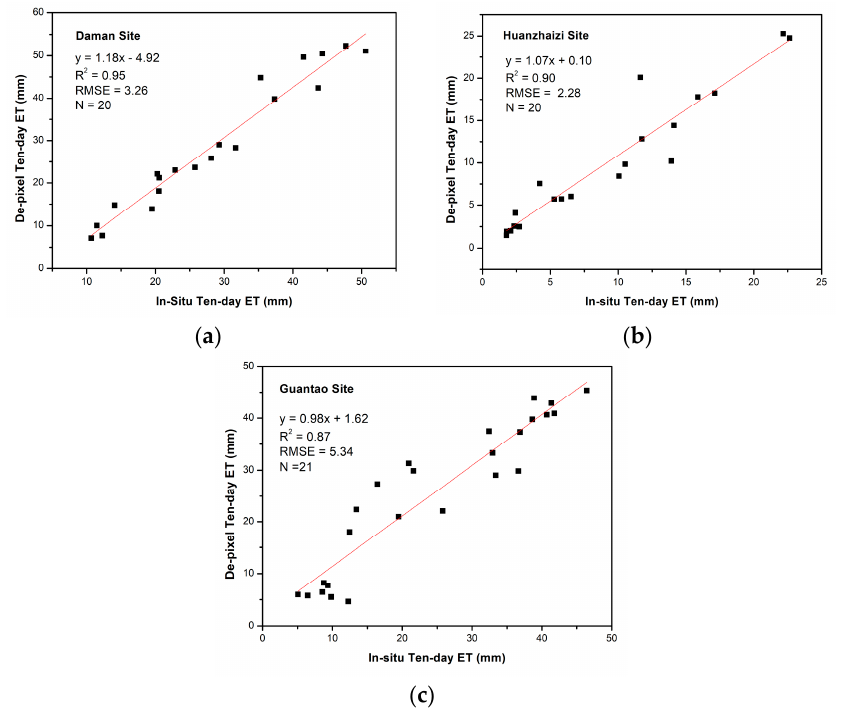
Figure 6. Comparison of the ten-day ETa values from in situ observations and downscaled 30-m ET values obtained using the “de-pixelation” method at three sites: ( a ) Daman; ( b ) Huazhaizi; and ( c ) Guantao.